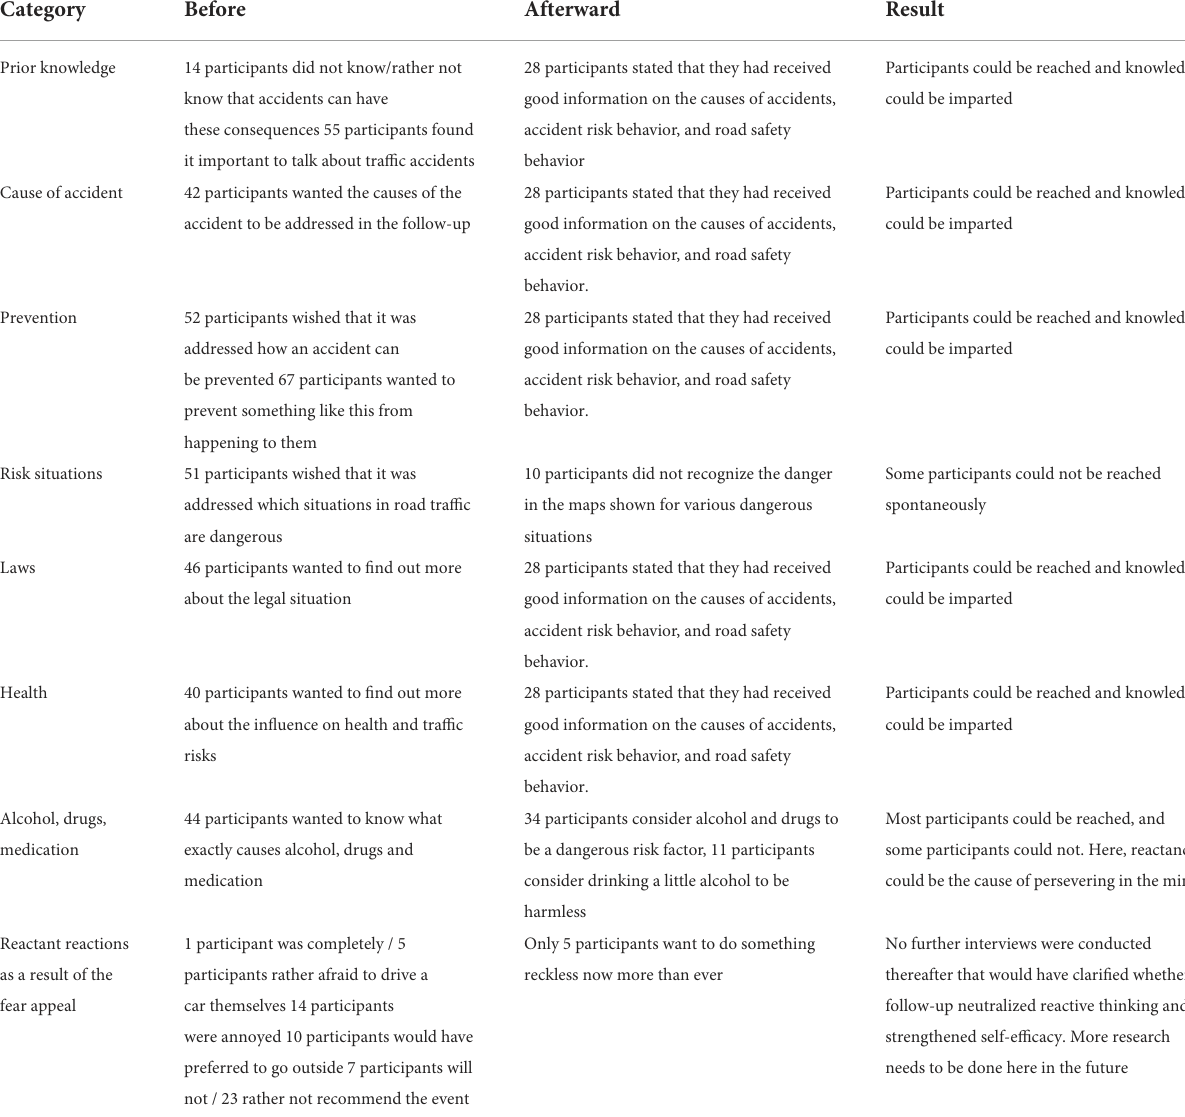
TABLE 3 Comparison of criteria of settings preliminary research ( n = 77) and post-test ( n = 57). Category